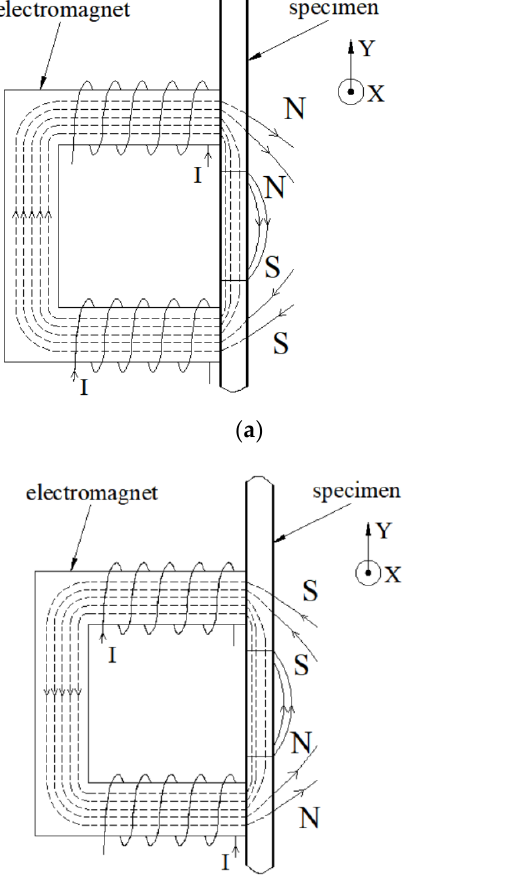
Figure 5. B Z distribution of the unloaded specimens under the DC magnetic field was applied at angles of ( a ) 0°; ( b ) 90°; ( c ) 180° ; ( d ) 270°.